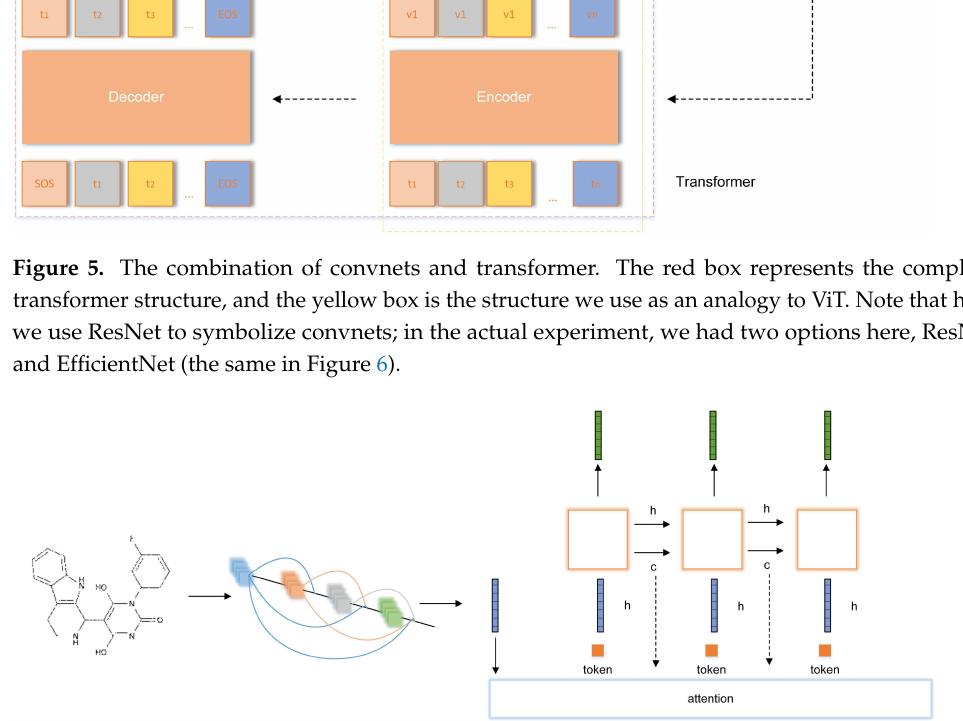
Figure 6. The structure of the model combined by convnet and RNN. The orange box represents the RNN structure. The 3D chemical image is processed by convnet to generate the feature vector and is processed by the attention mechanism to generate the attention vector for the token sequence, and the attention vector is fused with the token embedding. The state vector h, generated by the RNN at the previous time step, is also processed by the attention mechanism and fused with the previous two. It is used as the input for the current time